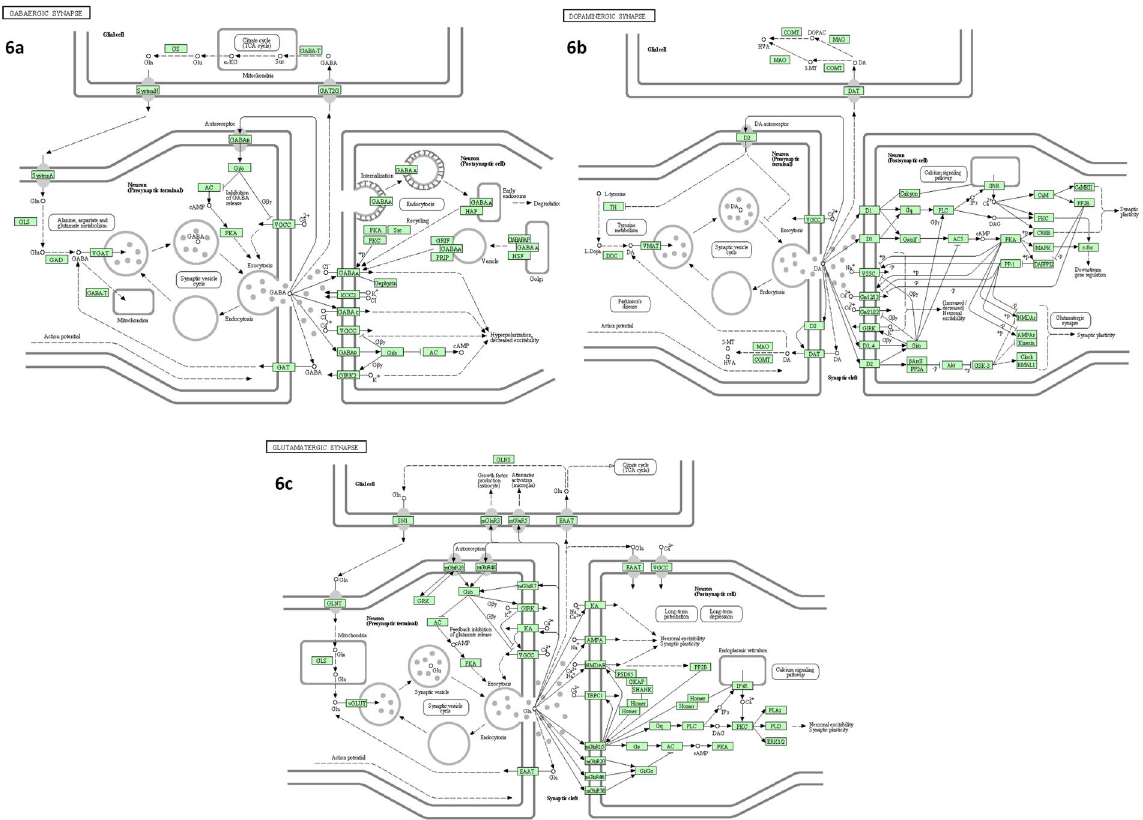
Figure 6. Mapping of predicted target genes in pathways related to various synaptic neurotransmission. ( a ) Mapping of genes were identified as predicted targets of upregulated miRNAs. Elaboration of canonical pathway related to GABAergic synapse function enriched with predicted target genes of upregulated miRNAs in the MDD-suicide group is shown. ( b ) Mapping of genes in dopaminergic synapse identified as predicted targets of upregulated miRNAs. Elaboration of canonical pathway related to dopaminergic synapse function enriched with predicted target genes of upregulated miRNAs in the MDD-suicide group is shown. ( c ) Mapping of genes in glutamatergic synapse identified as predicted targets of downregulated miRNAs. Elaboration of canonical pathway related to dopaminergic synapse function enriched with predicted target genes of downregulated miRNAs in the MDD-suicide group is shown. The pathway images are obtained from Kyoto Encyclopedia of Genes and Genomes